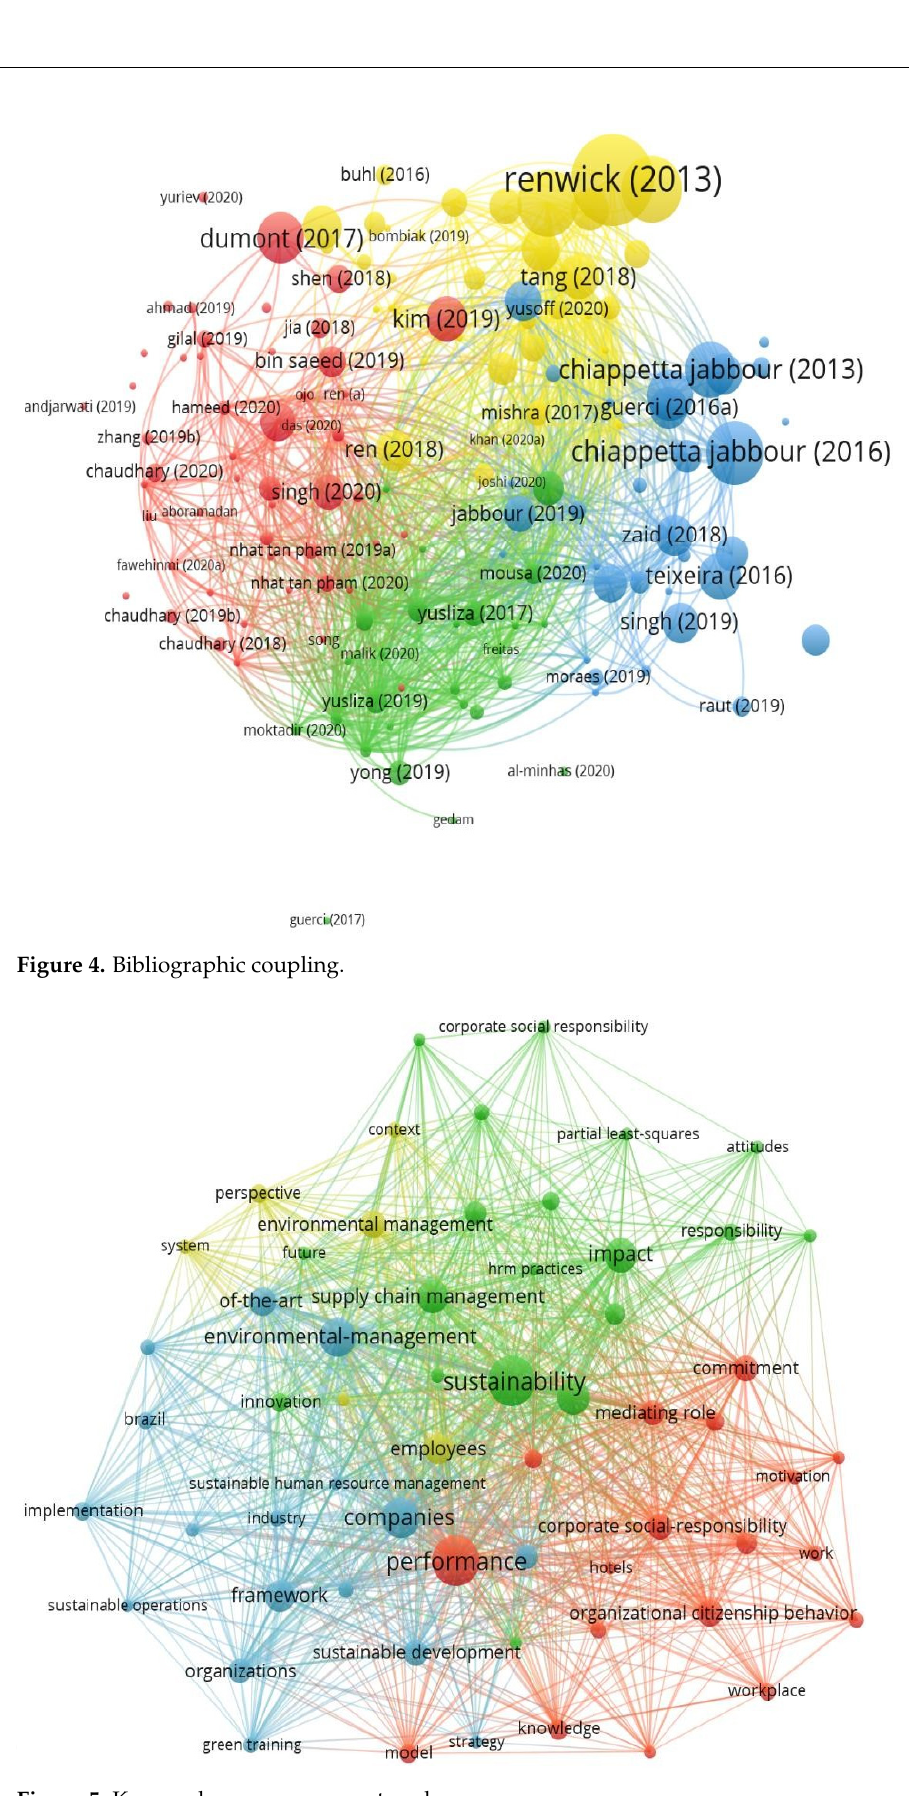
Figure 5. Keyword co-occurrence network.